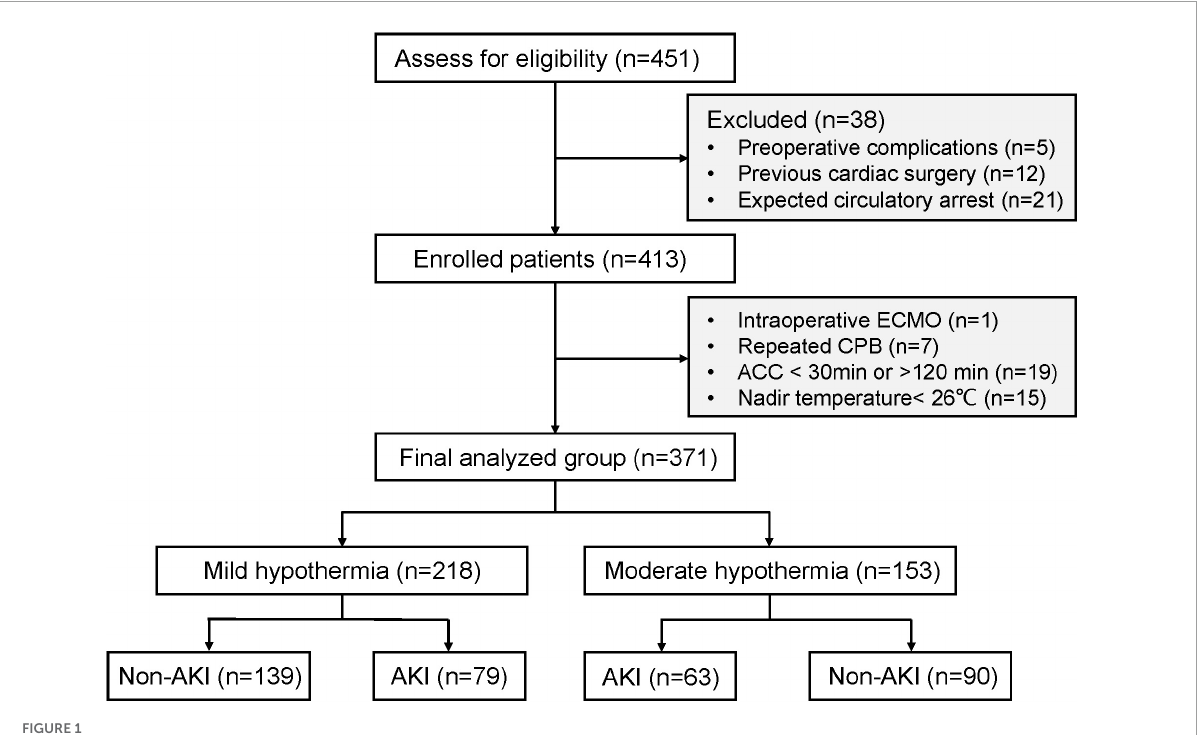
FIGURE1 Flow chart of the